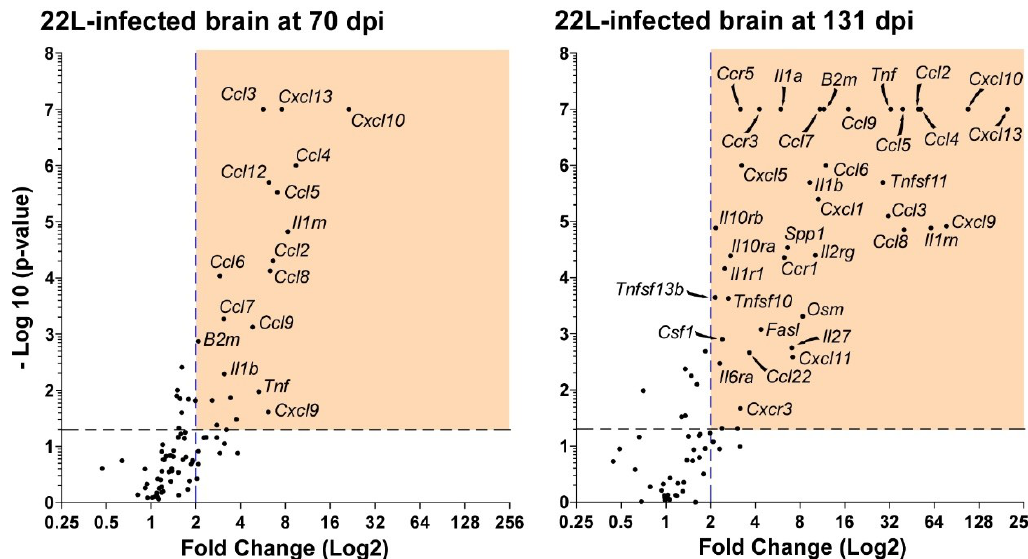
Figure 1. Quantitative reverse transcription-polymerase chain reaction (qRT-PCR) analysis of expression of 84 proinflammatory genes in the brains of mice at 70 compared to 131 days after prion infection. Each black dot correlates to the average gene expression seen in a minimum of three mice. The orange box is the region containing proinflammatory genes that are statistically significant by t -test ( p ≤ 0.05, the black dashed line) and greater than 2-fold increased (the blue dashed line) relative to mock infected control mice. The number and magnitude of the upregulated proinflammatory genes in the brain of prion infected mice intensifies as a function of time.